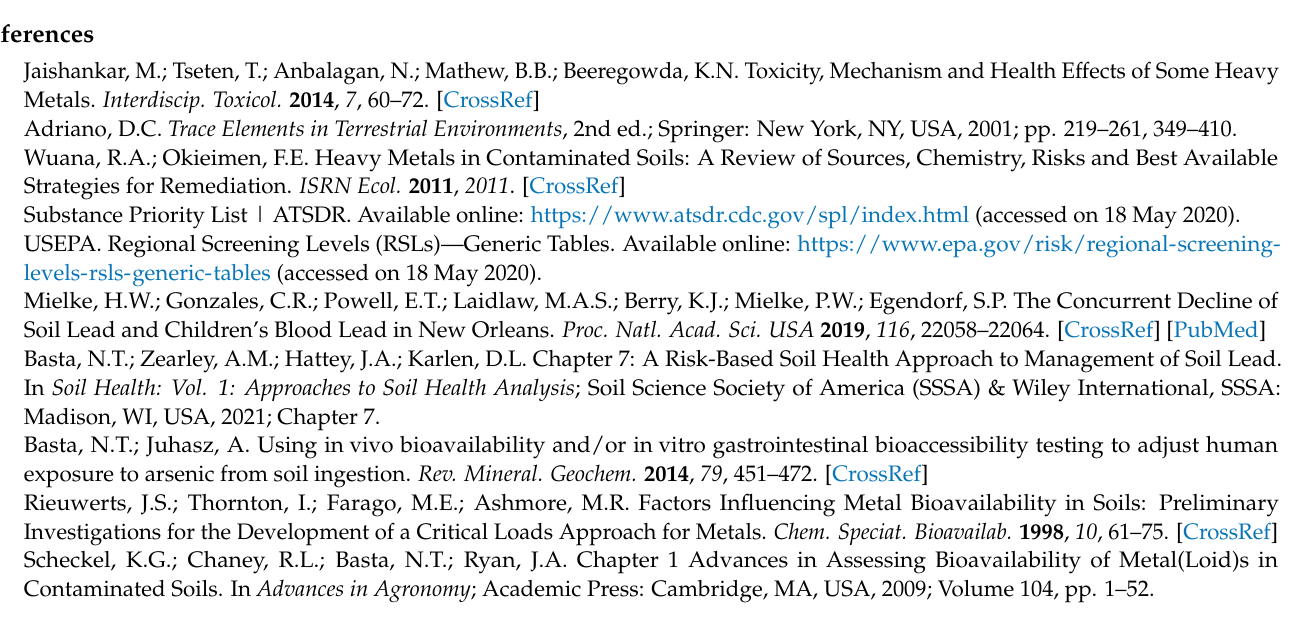
Table S4: Pb soil properties correlation analysis, Figure S1: Effect of soil type on %bio-accessible As, Figure S2: Effect of soil type on %bio-accessible